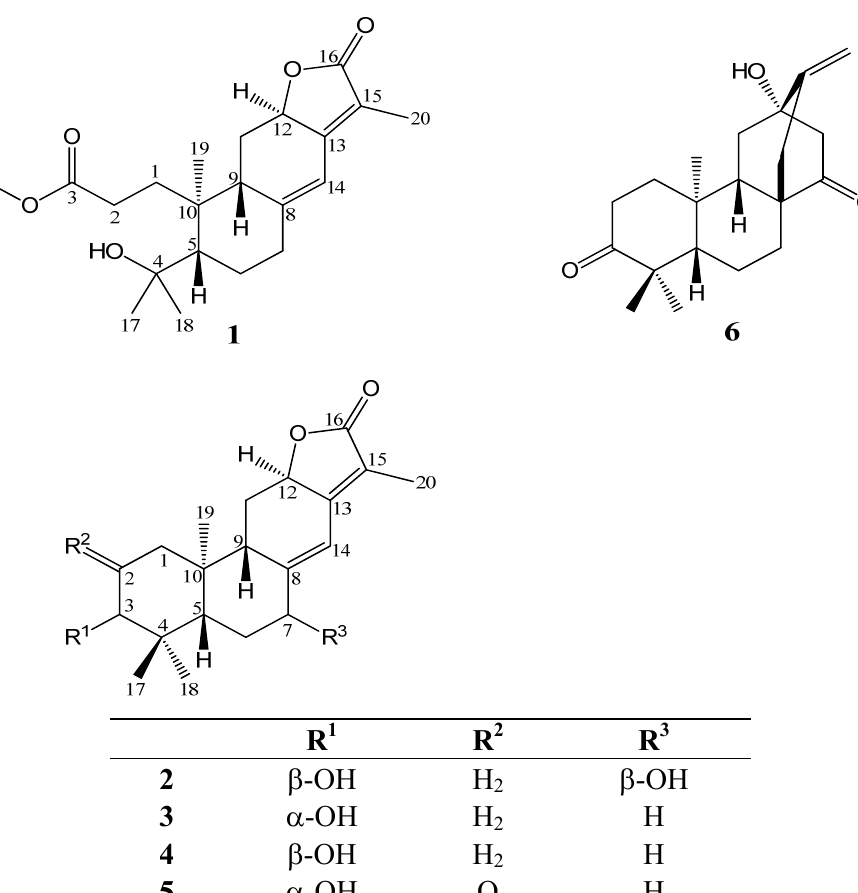
Figure 1. Chemical structures of compound 1 – 6